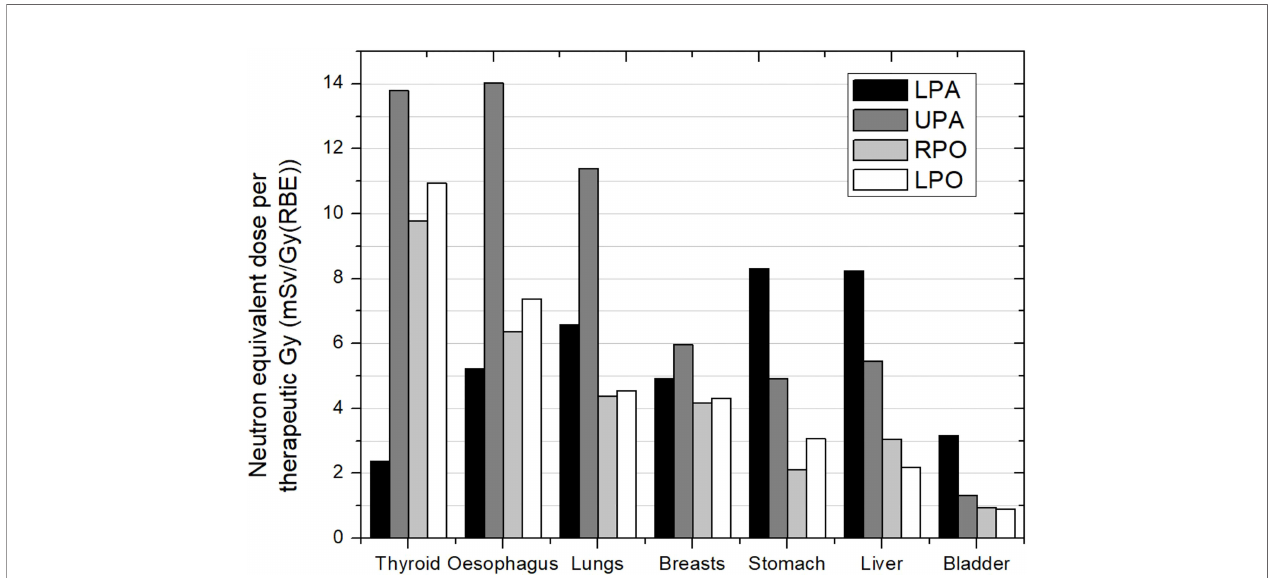
FIGURE 6 | Neutron equivalent doses per therapeutic Gy in selected organs for the different incidences in CSI. Spinal fi elds: LPA, lower posterior anterior; UPA, upper posterior anterior. Cranial fi elds: RPO, right posterior oblique and LPO, left posterior oblique. Data extracted from Taddei et al.